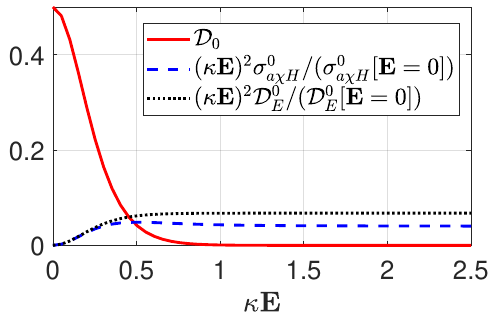
Figure 6. The (cid:12)rst order TCs as function of (cid:20) E when B =